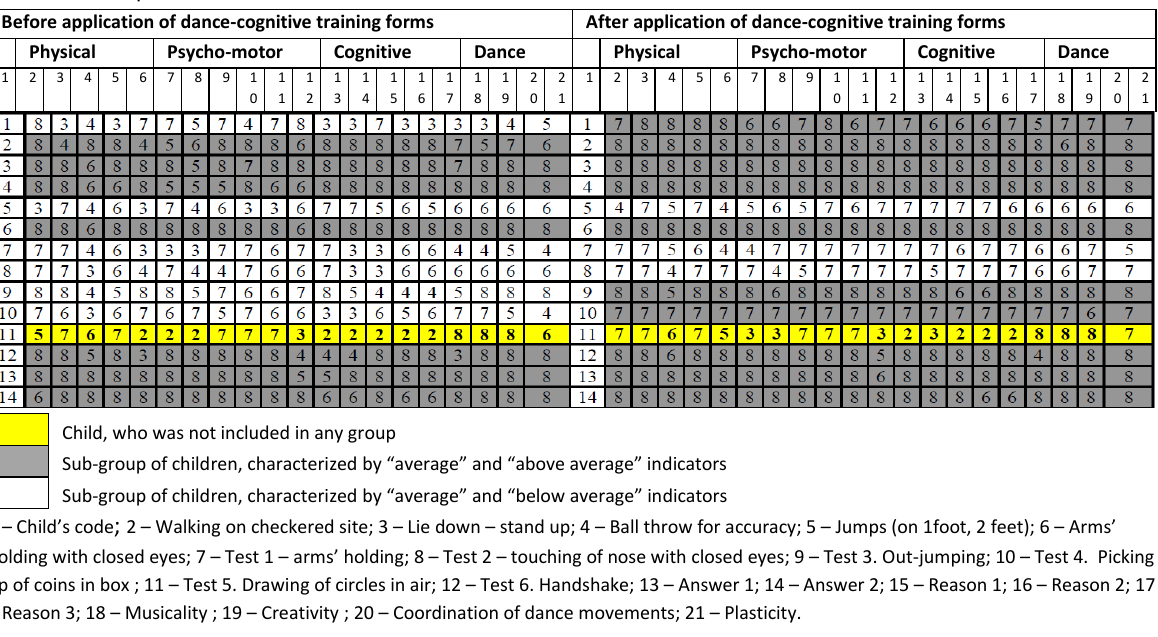
Table 1. Change of non-uniformity of cognitive and psycho-physical functions’ manifestations in 5-6 years’ age children with speech